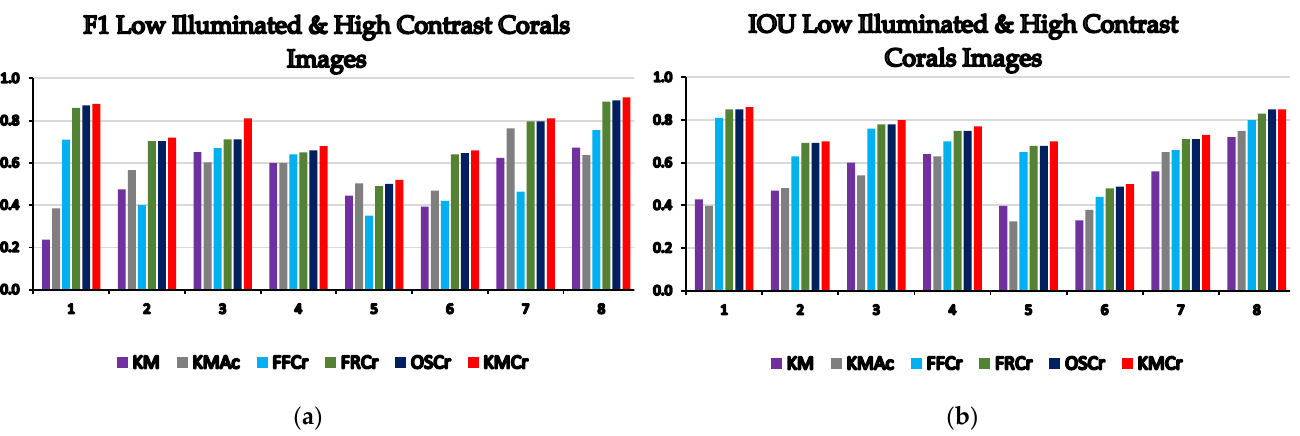
Figure 22. The results of evaluating the tested segmentation algorithms using low illuminated and high contrast corals images. Images (1 – 4) had two categories, and (5 – 8) had three categories: ( a ) F1- score; ( b ) IOU.